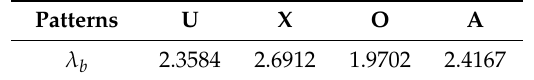
Table 3. Critical geometrical parameter λ b ( S / h = 80, a GPL /b GPL = 4, b GPL /t GPL = 10 3 , W GPL = 0.5%). Patterns